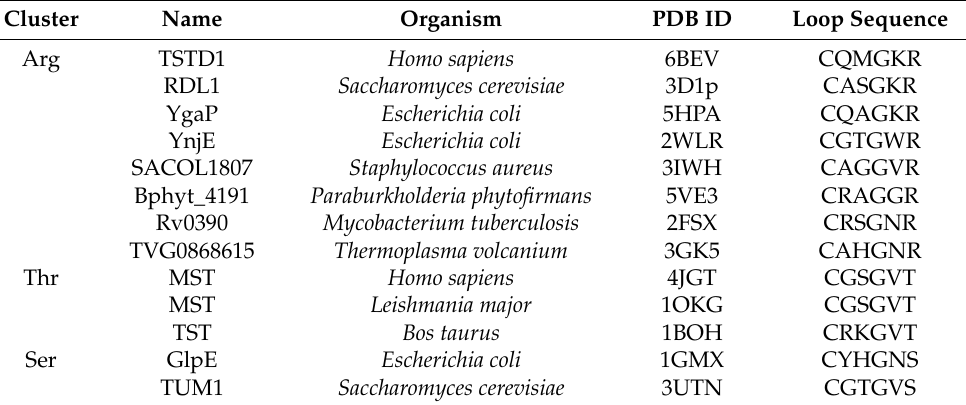
Table 4. Structured rhodaneses downloaded from the PDB database.